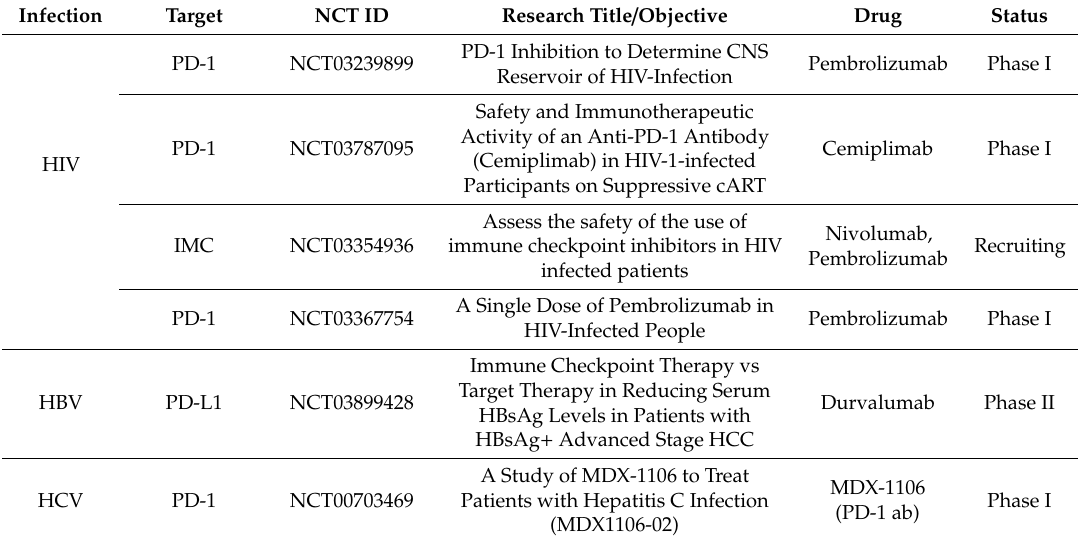
Table 3. Clinical trials on immune checkpoint inhibitors targeting viral